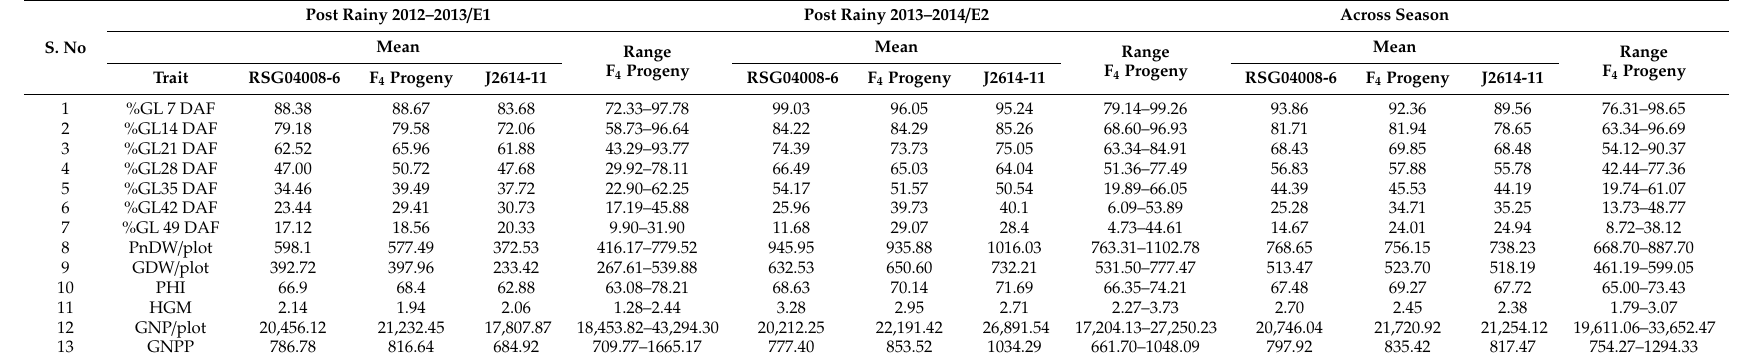
Table 1. Stay-green and grain-yield mean values.